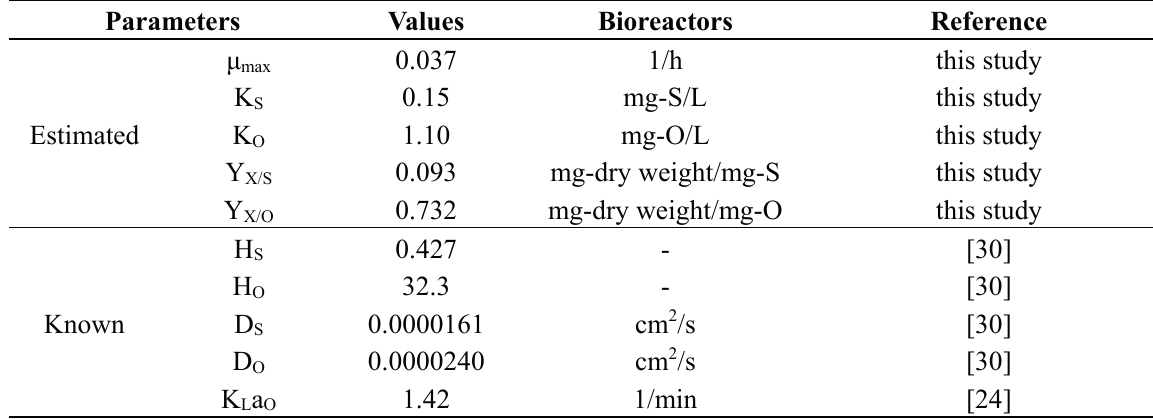
Table 1. Kinetic model parameters used in this